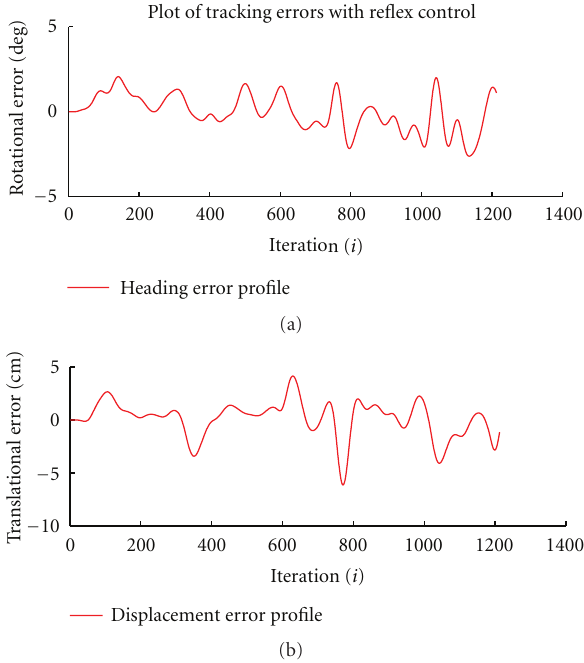
Figure 20: Tracking Errors using the proposed FRC method.